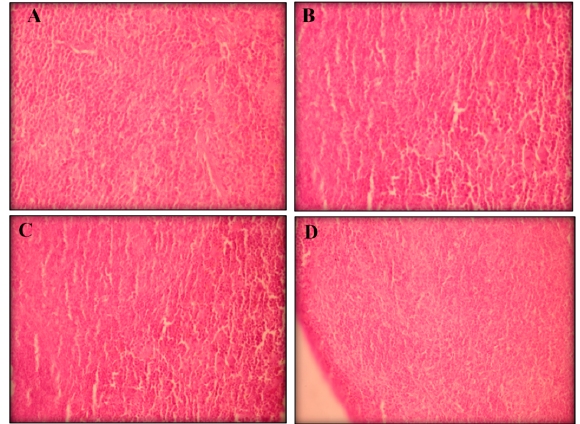
Figure 5. The effect of perillaldehyde 8,9-epoxide on spleens of healthy mice. Histopathology was analyzed by light microscopy and stained with hematoxylin-eosin (400×). Photos from liver represent: negative control ( A ); positive control 25 mg/kg/day 5-FU-treated ( B ); 100 mg/kg/day perillaldehyde 8,9-epoxide treated ( C ); and 200 mg/kg perillaldehyde 8,9-epoxide treated ( D ). Figure 6 shows histopathology of Sarcoma 180 tumor cells.